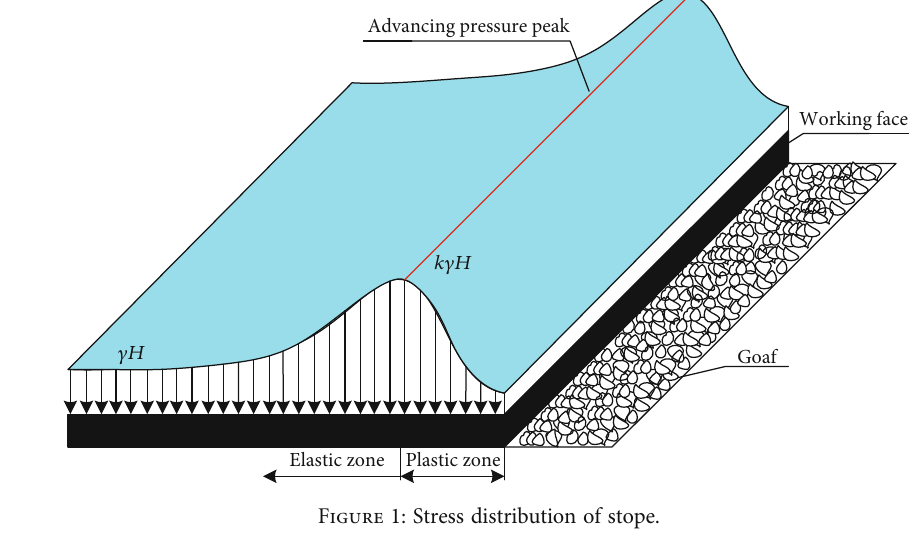
Figure 1: Stress distribution of stope.